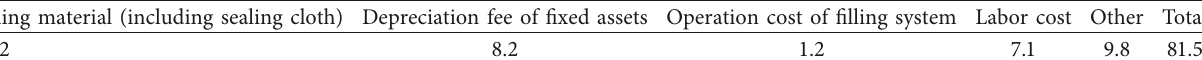
Figure 9: Relative position of surface subsidence curve. Table 5: Cost composition per ton of coal with Aeolian sand-like paste filling (unit: